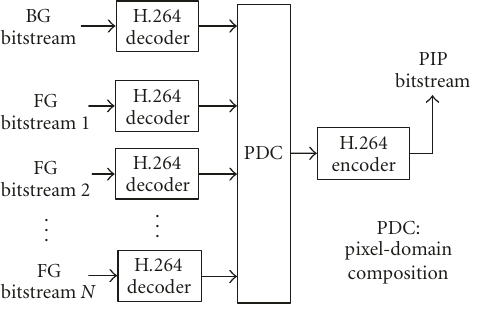
Figure 2: Architecture of the